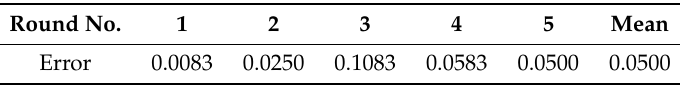
Table 3. Errors of the five random rounds using ProCRC.